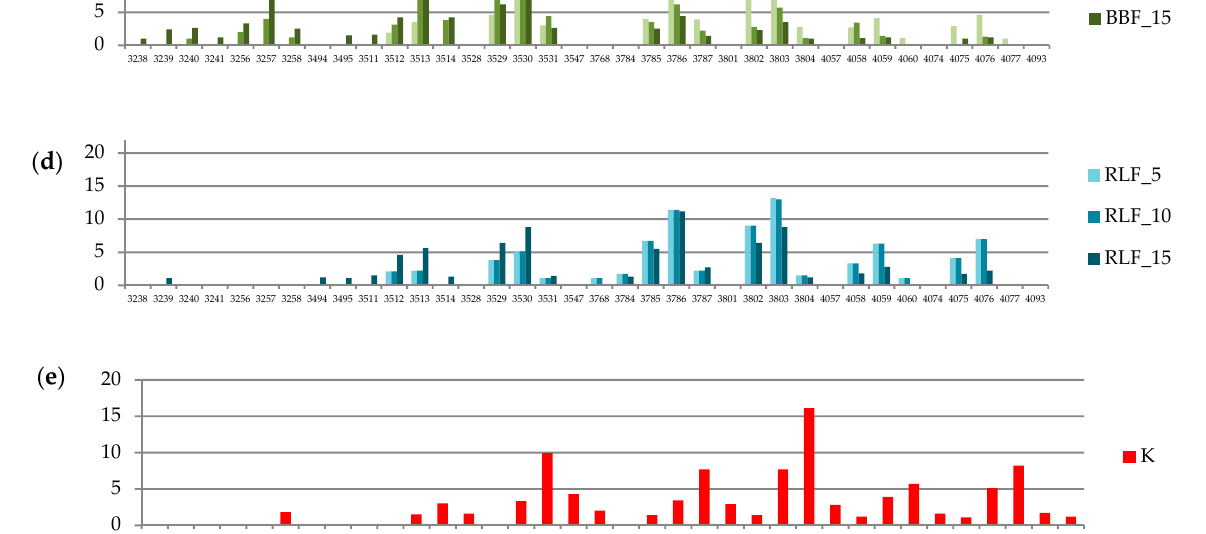
Figure 12. Color spectra by E-eye. ( a ) bread with addition of chickpea flour; ( b ) bread with addition of common bean flour; ( c ) bread with addition of broad bean flour; ( d ) bread with addition of red lentil flour; ( e ) control bread. K = WF(50) + RF(50); ChF_5 = WF(50) + RF(45) + ChF(5); ChF_10 = WF(50) + RF(40) + ChF(10); ChF_15 = WF(50) + RF(35) + ChF(15); CBF_5 = WF(50) + RF(45) + CBF(5); CBF_10 = WF(50) + RF(40) + CBF(10); CBF_15 = WF(50) + RF(35) + CBF(15); BBF_5 = WF(50) + RF(45) + BBF(5); BBF_10 = WF(50) + RF(40) + BBF(10); BBF_15 = WF(50) + RF(35) + BBF(15); RLF_5 = WF(50) + RF(45) + RLF(5); RLF_10 = WF(50) + RF(40) + RLF(10); RLF_15 = WF(50) + RF(35) + RLF(15).